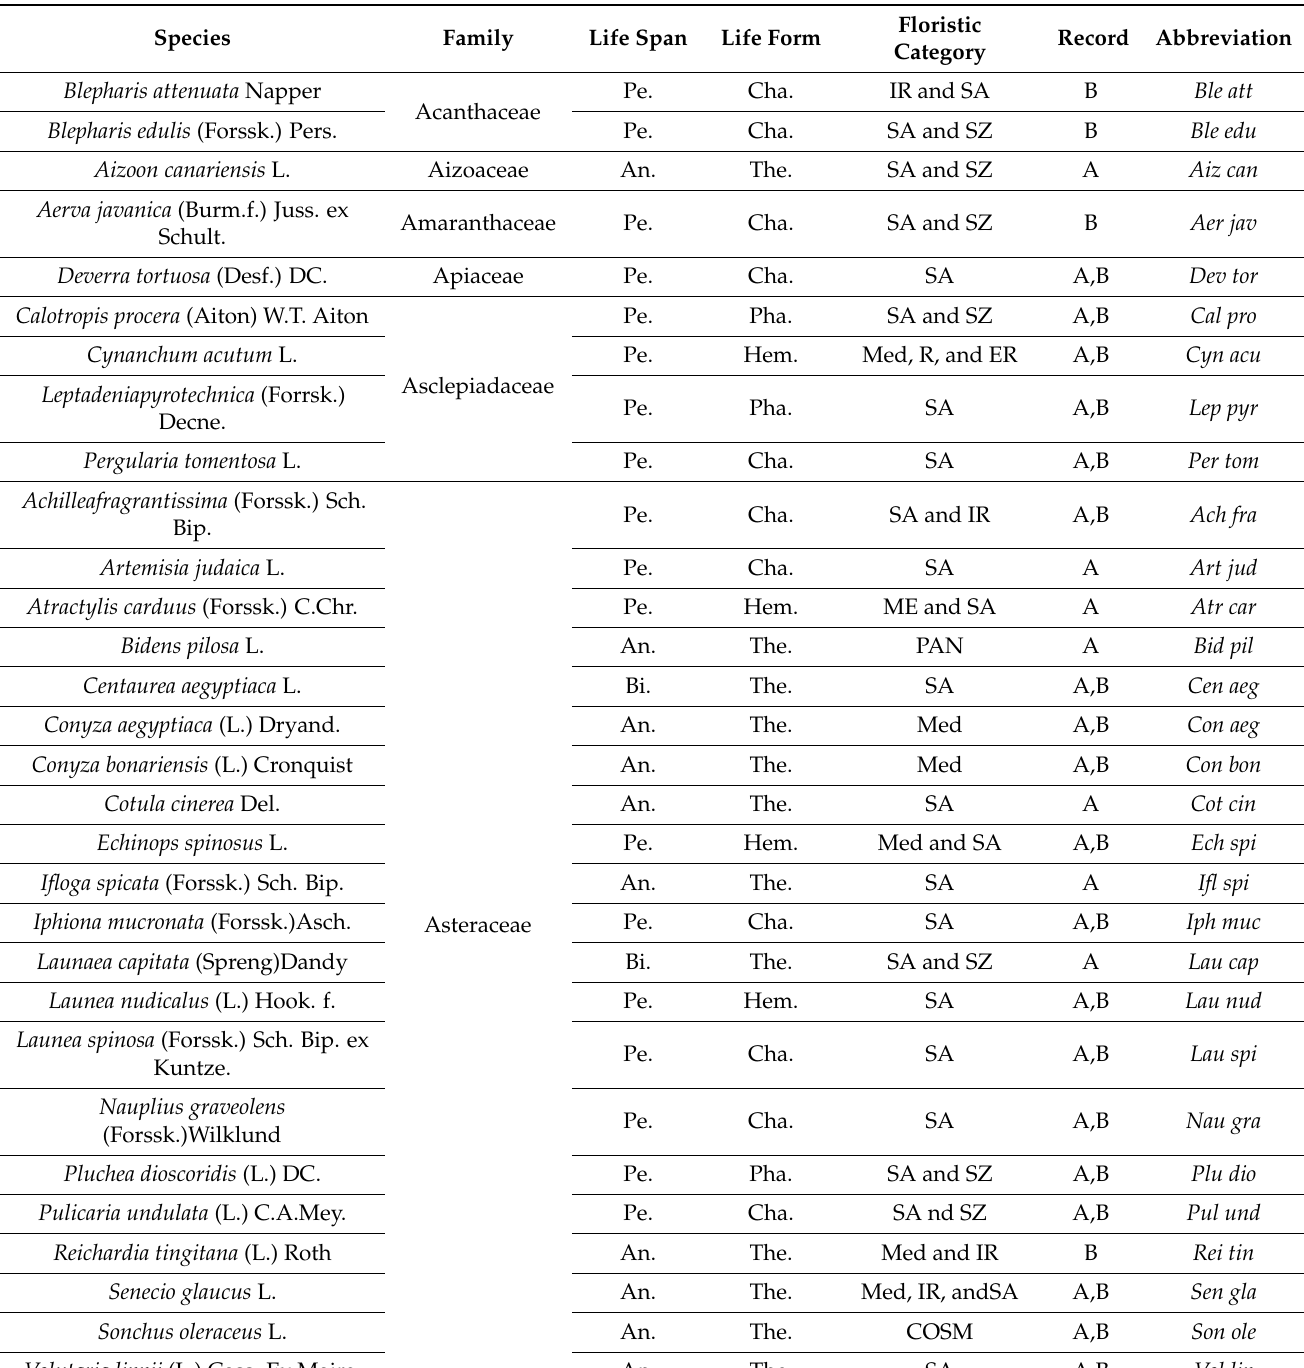
Table 2. The list of species recorded in Wadi Hagul with their plant families, life span, life form, floristic category, and abbreviations. Floristic Record Abbreviation Species Family Life Span Life Form Category Blepharis attenuata Napper Pe. Cha. IR and SA B Ble att Acanthaceae Blepharis edulis (Forssk.) Pers. Pe. Cha. SA and SZ B Ble edu Aizoon canariensis L. Aizoaceae An. The. SA and SZ A Aiz can Aerva javanica (Burm.f.) Juss. ex Amaranthaceae Pe. Cha. SA and SZ B Aer jav Schult. Deverra tortuosa (Desf.) DC. Apiaceae Pe. Cha. SA A,B Dev tor Calotropis procera (Aiton) W.T. Aiton Pe. Pha. SA and SZ A,B Cal pro Cynanchum acutum L. Pe. Hem. Med, R, and ER A,B Cyn acu Asclepiadaceae Leptadeniapyrotechnica (Forrsk.) Pe. Pha. SA A,B Lep pyr Decne. Pe. Cha. SA A,B Per tom Achilleafragrantissima (Forssk.) Sch. Pe. Cha. SA and IR A,B Ach fra Bip. Artemisia judaica L. Pe. Cha. SA A Art jud Atractylis carduus (Forssk.) C.Chr. Pe. Hem. ME and SA A Atr car Bidens pilosa L. An. The. PAN A Bid pil Centaurea aegyptiaca L. Bi. The. SA A,B Cen aeg Conyza aegyptiaca (L.) Dryand. An. The. Med A,B Con aeg Conyza bonariensis (L.) Cronquist An. The. Med A,B Con bon Cotula cinerea Del. An. The. SA A Cot cin Echinops spinosus L. Pe. Hem. Med and SA A,B Ech spi Ifloga spicata (Forssk.) Sch. Bip. An. The. SA A Ifl spi Iphiona mucronata (Forssk.)Asch. Pe. Cha. SA A,B Iph muc Asteraceae Launaea capitata (Spreng)Dandy Bi. The. SA and SZ A Lau cap Launea nudicalus (L.) Hook. f. Pe. Hem. SA A,B Lau nud Launea spinosa (Forssk.) Sch. Bip. ex Pe. Cha. SA A,B Lau spi Kuntze. Nauplius graveolens Pe. Cha. SA A,B Nau gra (Forssk.)Wilklund Pluchea dioscoridis (L.) DC. Pe. Pha. SA and SZ A,B Plu dio Pulicaria undulata (L.) C.A.Mey. Pe. Cha. SA nd SZ A,B Pul und An. The. Med and IR B Rei tin Senecio glaucus L. An. The. Med, IR, andSA A,B Sen gla Sonchus oleraceus L. An. The. COSM A,B Son ole Volutaria lippii (L.) Cass. Ex